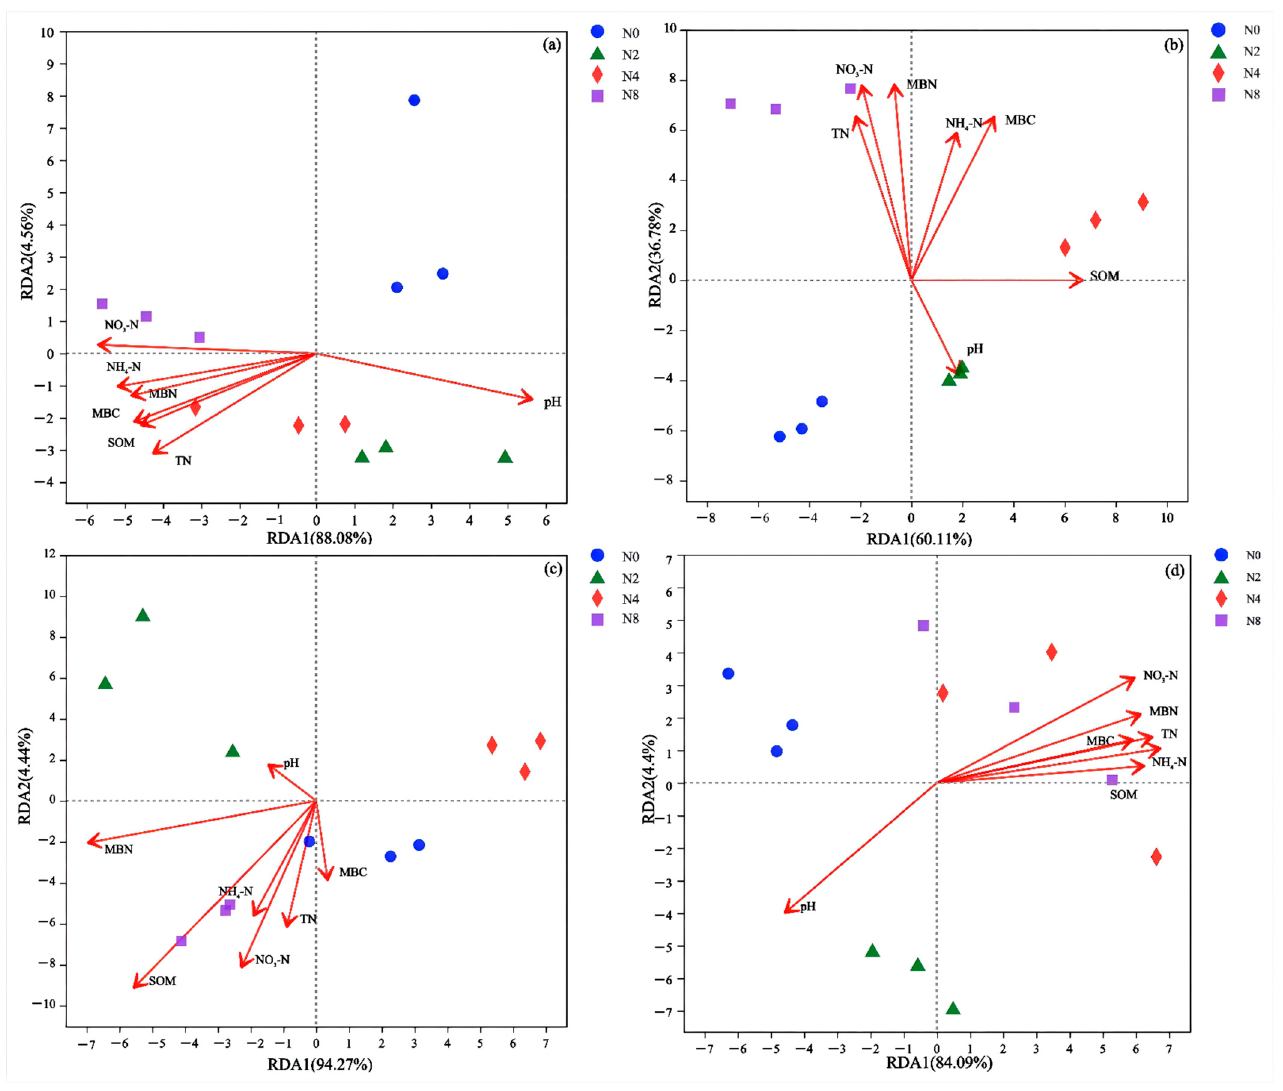
Figure 6. Redundancy analysis (RDA) results of soil and microbial properties and vegetation func- tional groups in grazing sheep and mowing grasslands under different nitrogen deposition back- grounds: ( a ) CK; ( b ) M1; ( c ) G1; ( d ) G2. Significance ( p < 0.05) was assessed using 999 permutations of the complete RDA. pH: soil potential of hydrogen; TN: soil total nitrogen; NO 3 -N: soil nitrate- nitrogen; NH 4 -N: soil ammonium nitrogen; SOM: soil organic matter; MBC: soil microbial biomass nitrogen; MBN: soil microbial biomass carbon.